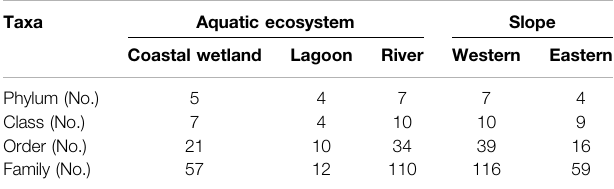
TABLE 4 | Distribution of macroinvertebrate taxa by hydrographic slope and aquatic ecosystem, according to research studies carried out between